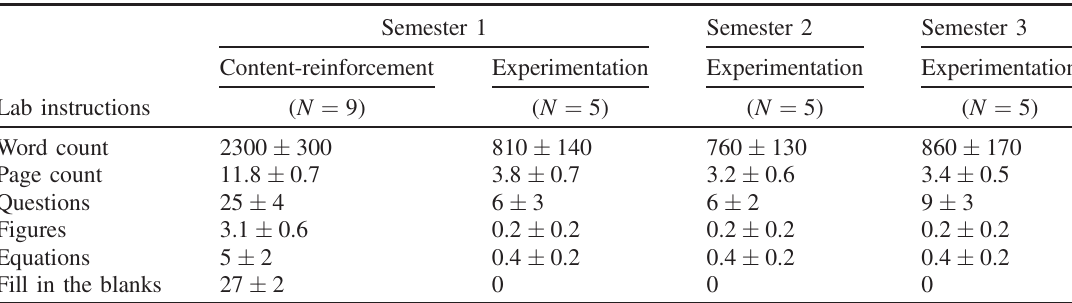
TABLE VII. Descriptions of lab instructions to illustrate the differences in materials used in content-reinforcement and experimentation labs. Counts are reported with means and standard errors. Question count includes fill-in-the- blanks questions and questions posed for students to consider as part of the instructions. Over 9 weeks, there are nine lab instruction packets for the content-reinforcement labs and five packets for the experimentation labs; the counts are averaged by lab instruction packet.